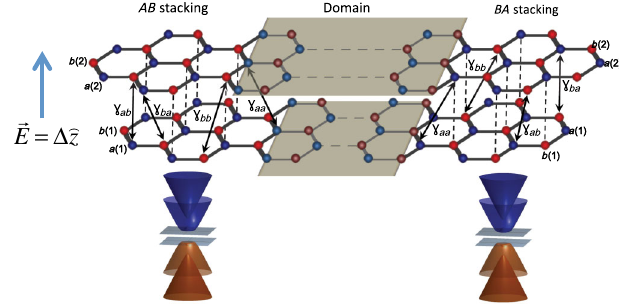
FIG. 1. A typical AB - BA tilt boundary under strain. The blue (red) filled circles mark the a ( b ) sublattice sites. (cid:1) hopping matrices for a tight-binding model.